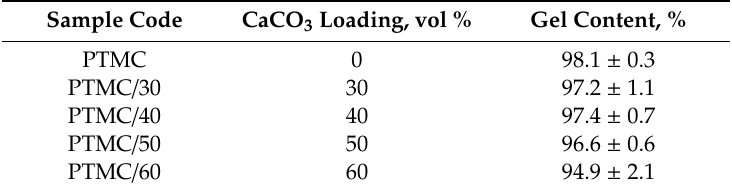
Table 2. Gel contents of poly(trimethylene carbonate) (PTMC) and PTMC / CaCO 3 composite films.